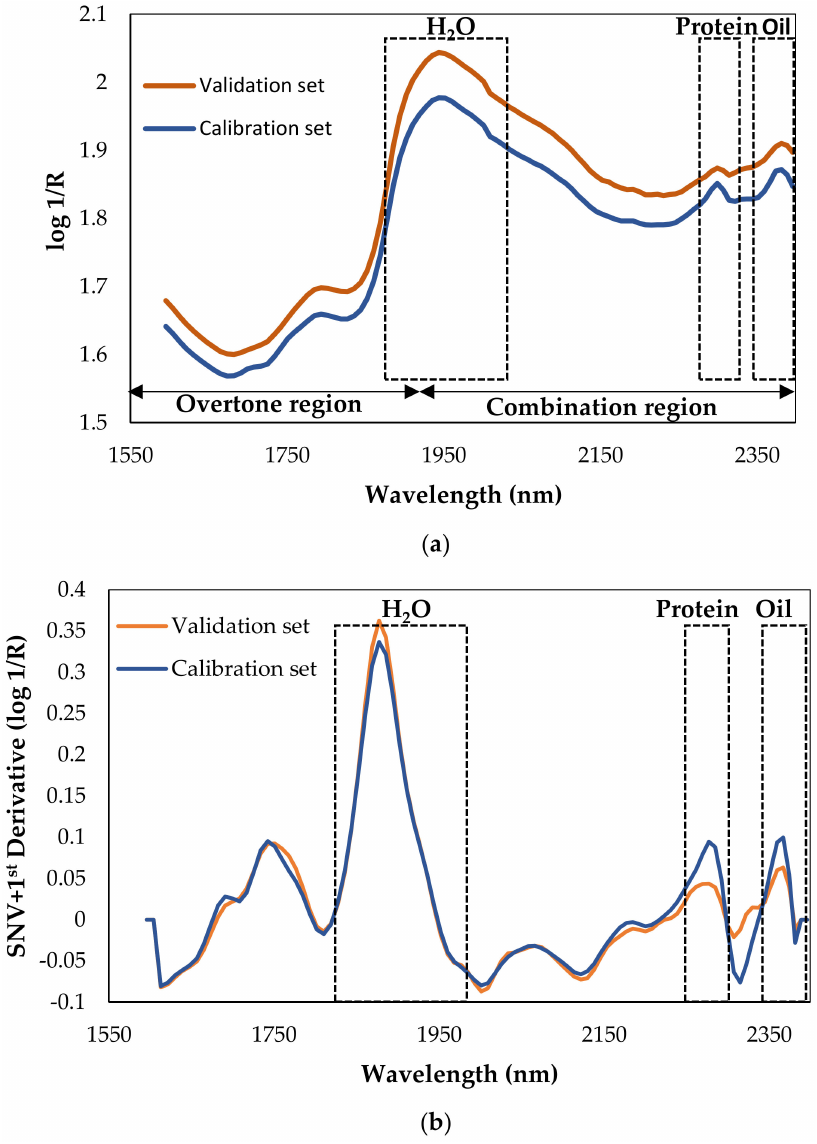
Figure 2. Average spectra of the calibration and validation sets: ( a ) raw spectra; ( b ) SNV + first derivative